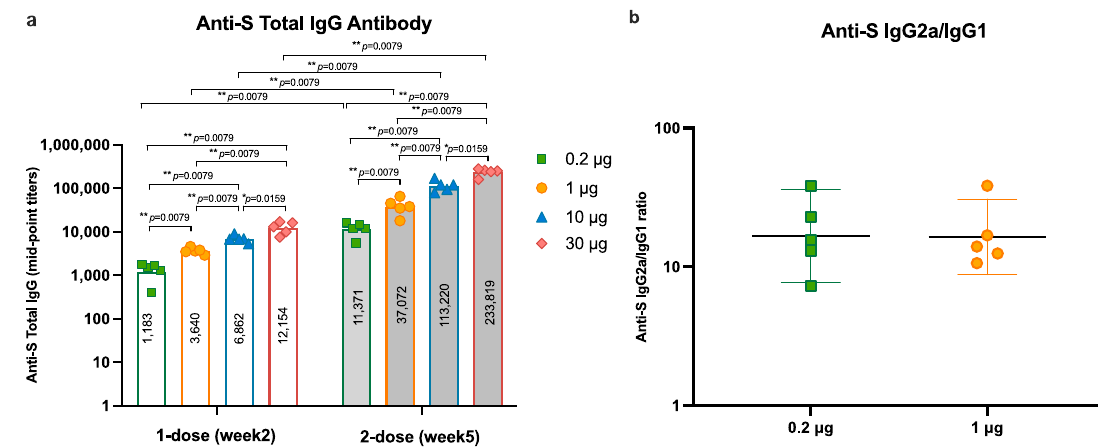
Fig. 3 | S-speci fi c IgG responses in ChulaCov19 immunized mice. a Kinetics of total IgG at 2 weeks after receiving 1 or 2 doses of 0.2, 1, 10, and 30 µ g of Chula- Cov19. b S-speci fi c IgG2a/IgG1 ratio measured at 2 weeks after the 2 nd dose. Note; the IgG2a/IgG1 ratio of 10 µ g and 30 µ g immunized mice were not analyzed due to limited volume of serum samples. The mid-point titers were determined in dupli- cateassaysfrom5miceineachgroup.Bars( a )orhorizontallines( b )representthe